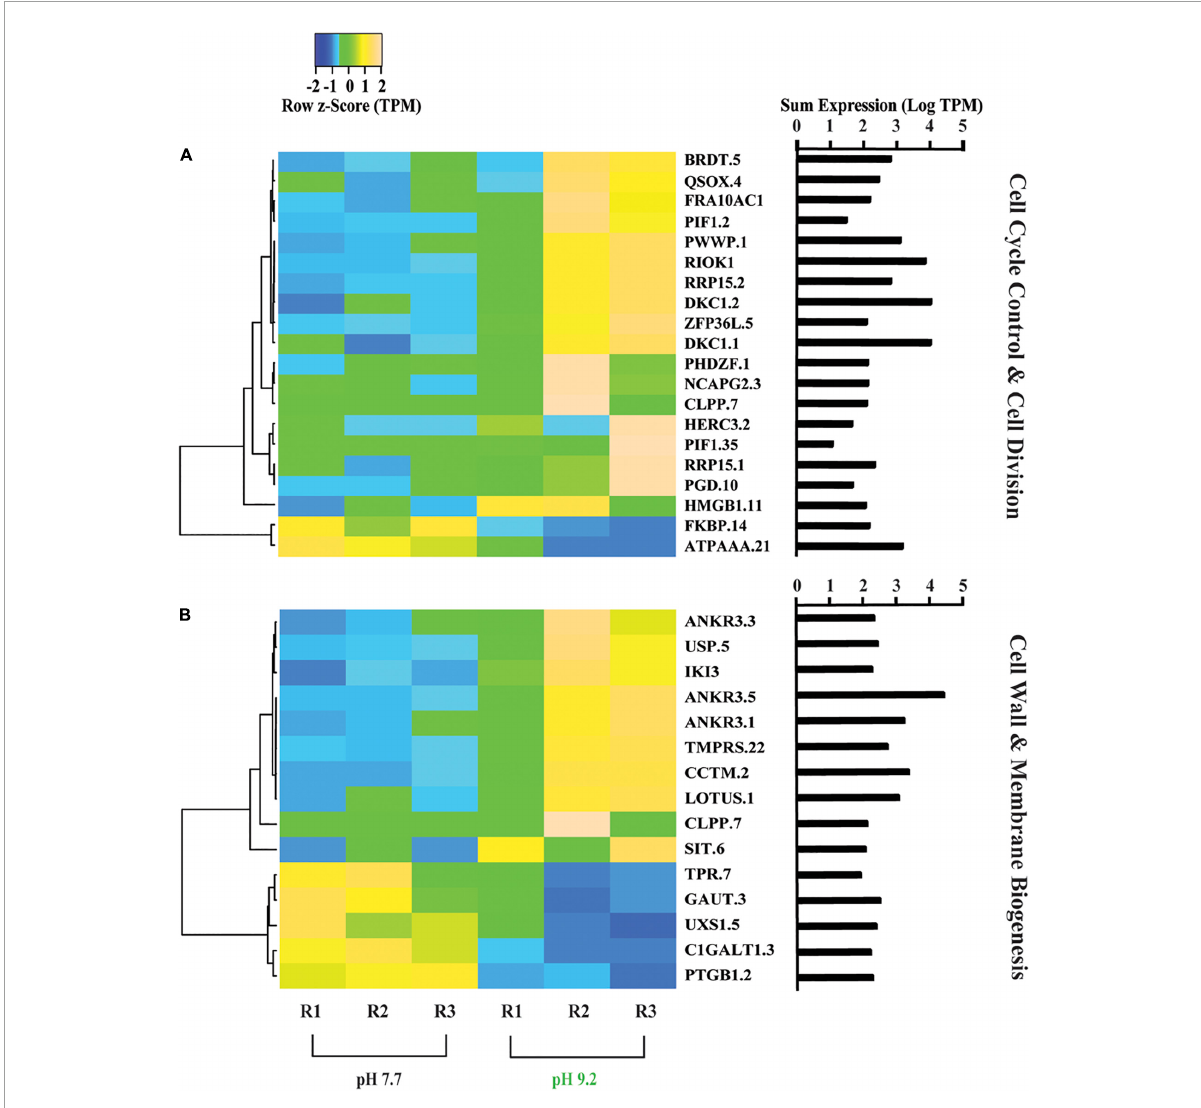
FIGURE1 Heat maps depicting differentially expressed genes relating to F. crotonensis growth and cell wall morphology. (A) Genes in the COG category “Cell cycle control, cell division, and chromosome partitioning”. (B) Genes in the COG category “Cell wall, membrane, envelope biogenesis”. Cladogram clustering is to demonstrate similarity in expression. All TPM values were row z-scored, with increases in proportional transcript abundance indicated in yellow, and decreases in proportional transcript abundance indicated in blue. The sum of transcripts across all treatments (LogTPM) is indicated for each